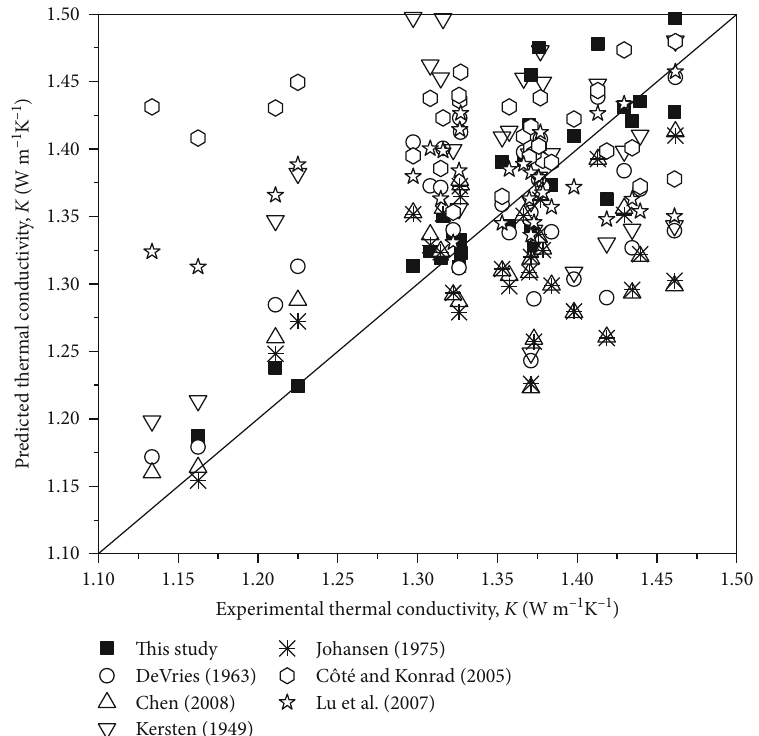
Figure 15: Comparison between di ff erent thermal conductivity predictive